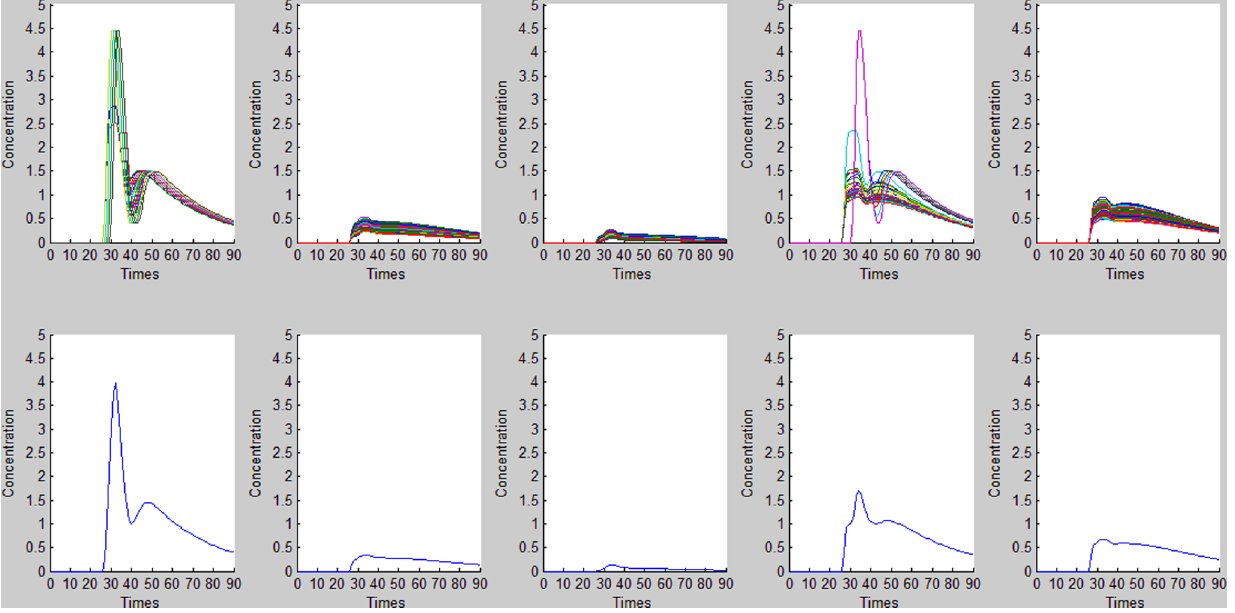
Figure 1. FCM cluster analysis results for AIF detection. Top: time–concentration curves for different clusters. Bottom: mean curve for M values of 0.0182, 1.9697e-004, 1.7418e-004, 0.0016, 3.9782e-004, respectively. The mean curve for M =0.0182 was thus selected to represent the estimated AIF.